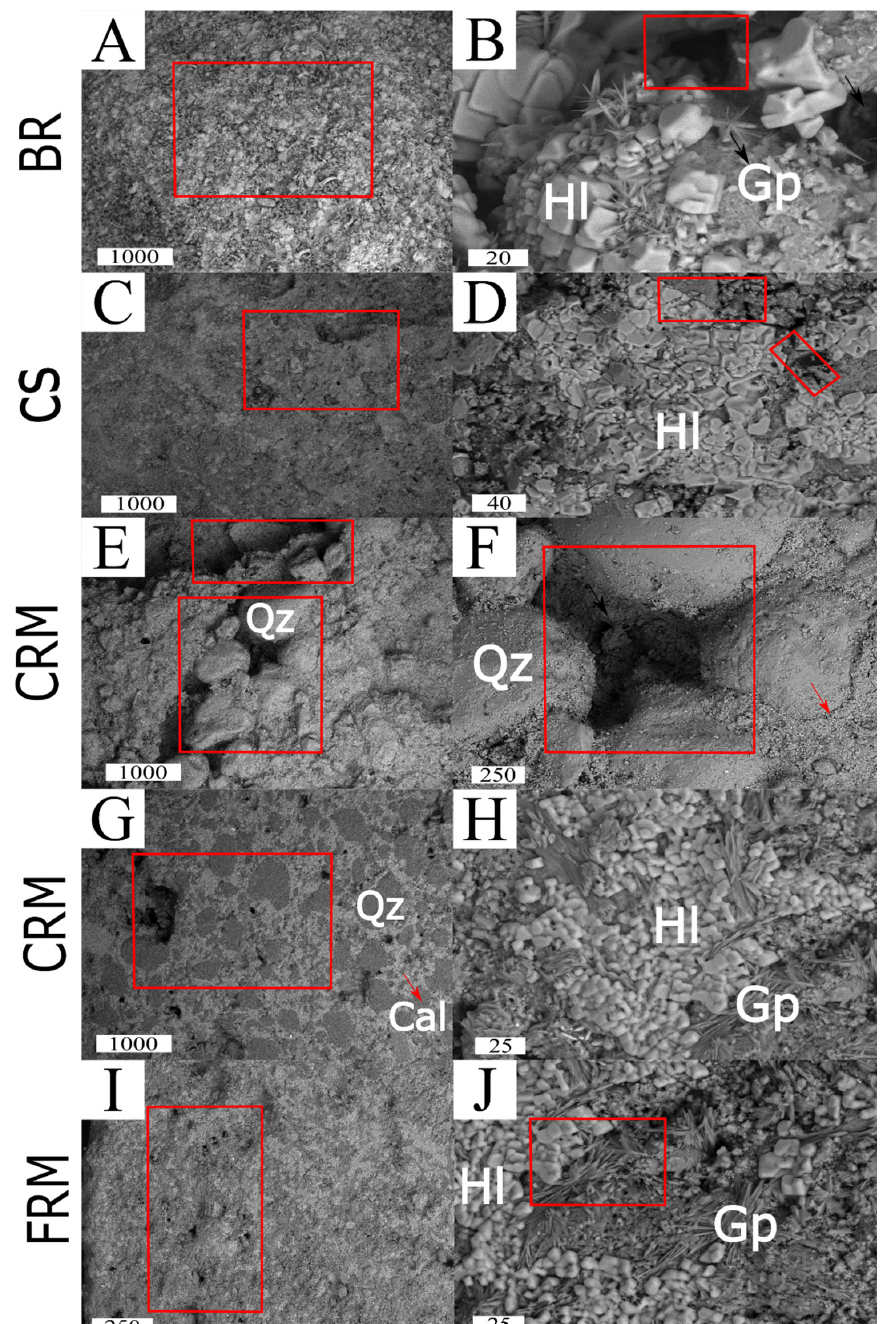
Figure 18. Micromorphological features of the construction building materials of Anfushi’s Necropo- lis. ( A , B ) The oolitic limestone (BR, bedrock) surface texture with halite cubic crystals and needle-like gypsum. ( C , D ) The fossiliferous micritic limestone (CS, casing stone) morphological texture with halite crystal perceptions, pores and microfissures. ( E – H ) The coarse-grained rendering mortar (CRM) textural features with disintegrated grains, precipitation of halite (cubes), gypsum (needles), and detection of gaps and pitting. ( I , J ) Fine-grained rendering mortar (FRM) textural aspects with depositing halite mixed with needle-like crystals of gypsum, in addition to gaps and pitting. Red squares and rectangles refer to the disintegration feature of the samples due to salt weathering impact. Scales are expressed in microns. BR: bedrock; CS casting stone; CRM: coarse-grained rendering mortar; FRM: fine-grained rendering mortar; Hl: halite; Cal: calcite; Qz: quartz; Gp: